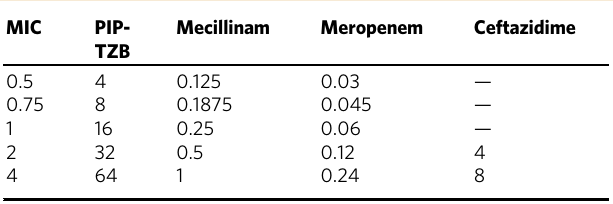
Table 1 Concentrations of antibiotics used for screening the CTX-M-15